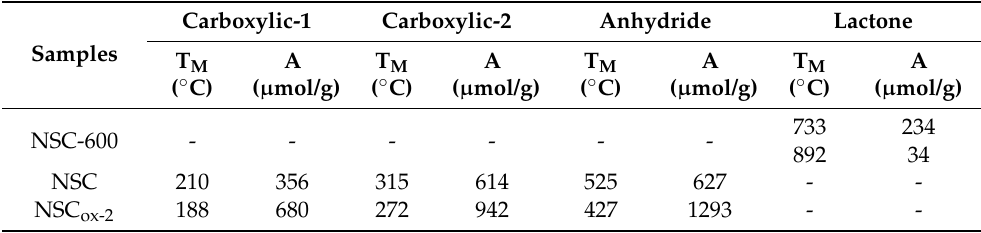
Table 3. Results of the deconvolution of CO-TPD spectra using a multiple Gaussian function.